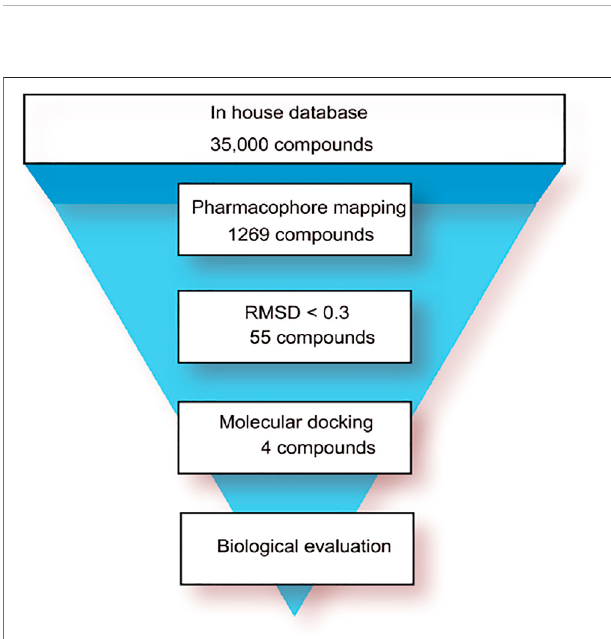
FIGURE 2 | A work fl ow overview of pharmacophore modeling and selection of hit